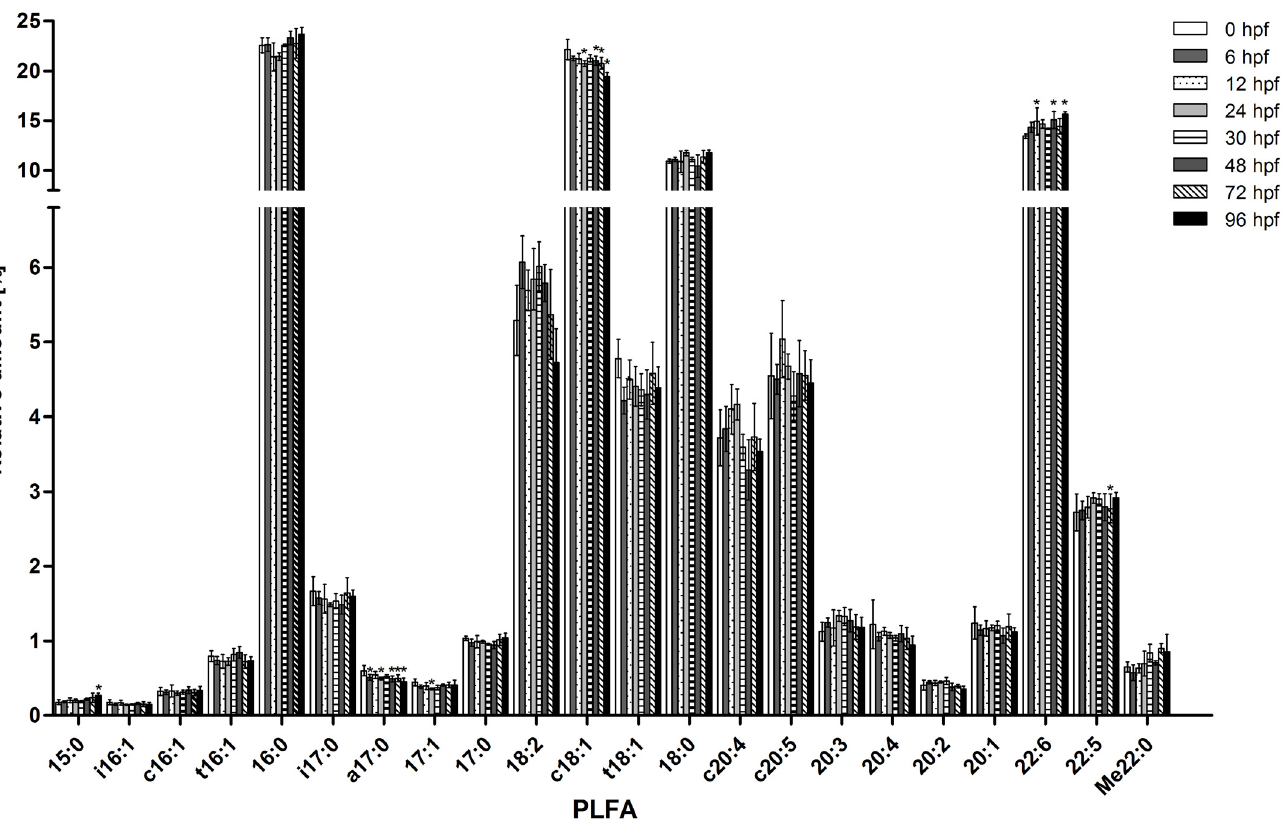
Fig 3. Relative amounts of phospholipid fatty acid (PLFA) fractions in eggs/hatched embryos of the zebrafish at 0 – 96 hpf (one bar for each stage). n = 3 – 4 with 50 pooled embryos per n; hpf: hours post fertilization. Note that the y-axis is divided into two sections with different scales.